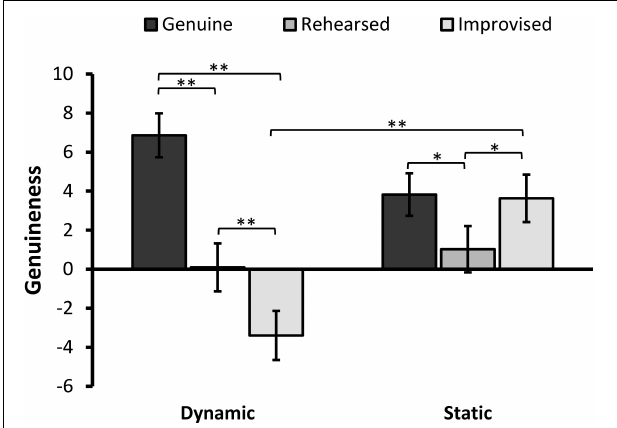
FIGURE 2 | Mean ratings for perceived genuineness of facial expressions (error bars ± 1 SE). Positive values indicate that expressions were perceived as more genuine, while negative values indicate that they were perceived as more fake. The asterisks represent a significant difference at ∗ p < 0.005 and ∗∗ p <